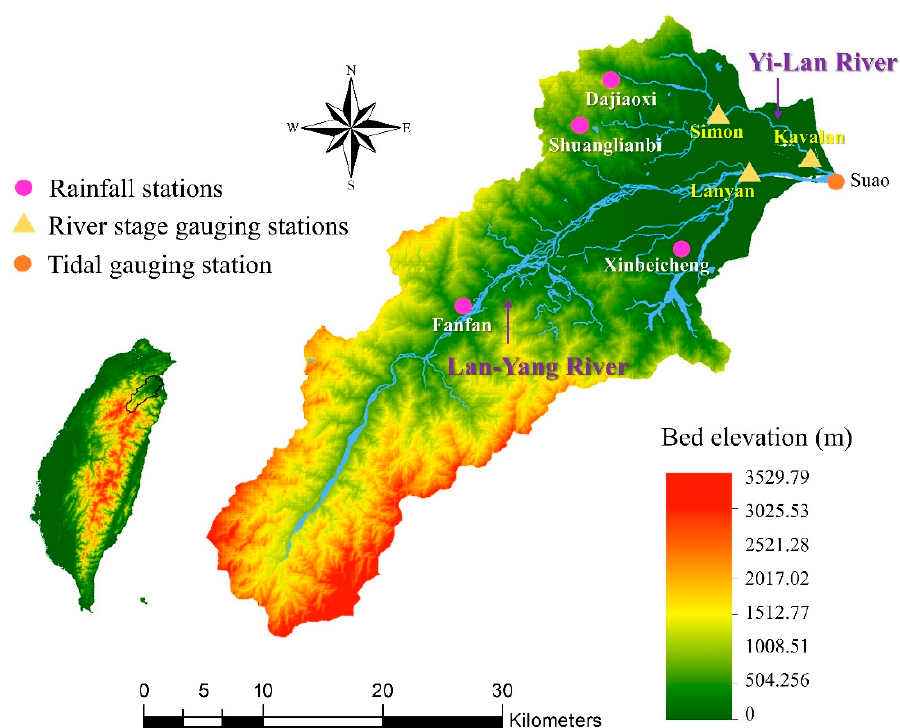
Figure 3. The map of study area displaying the locations of hydrological stations.